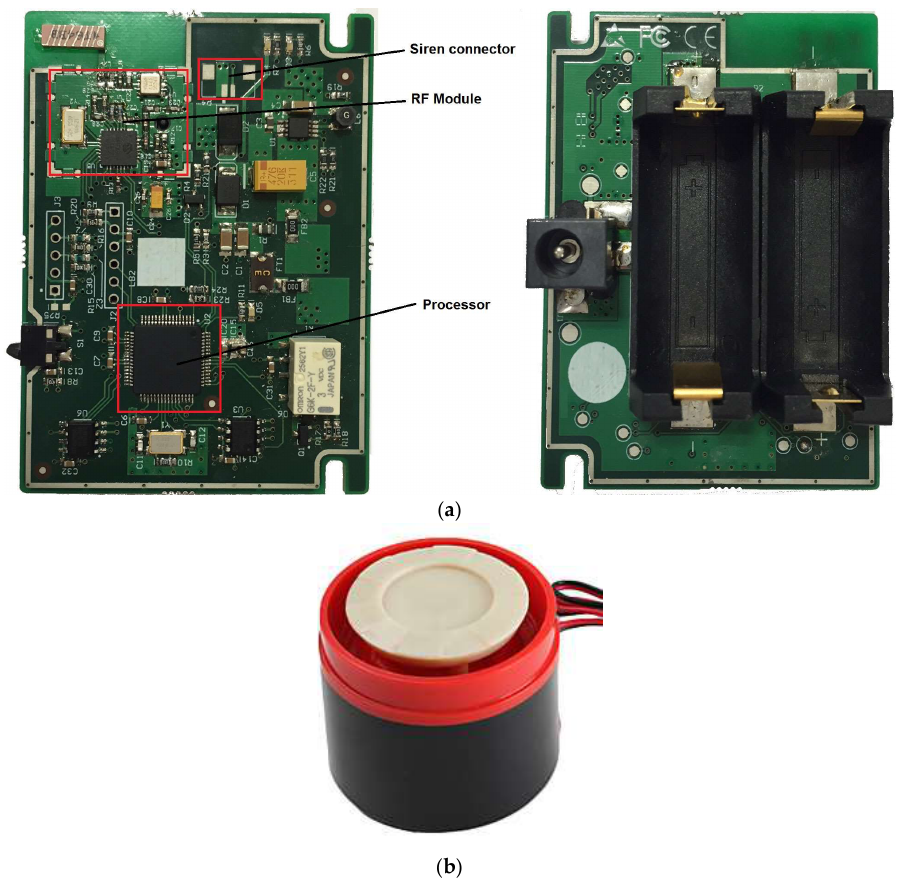
Figure 7. ( a ) Photographs of the siren circuitry; ( b ) Commercial siren.